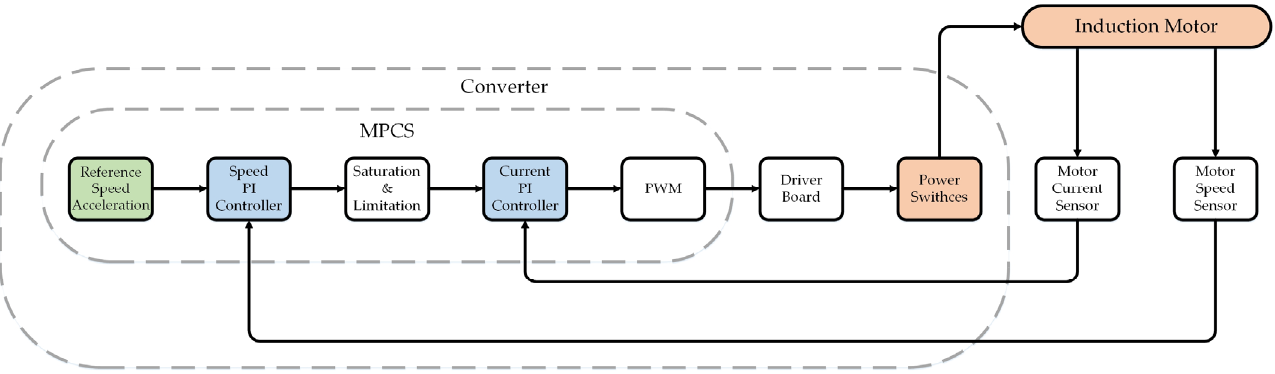
Figure 15. Block diagram of connecting converter to induction motor.